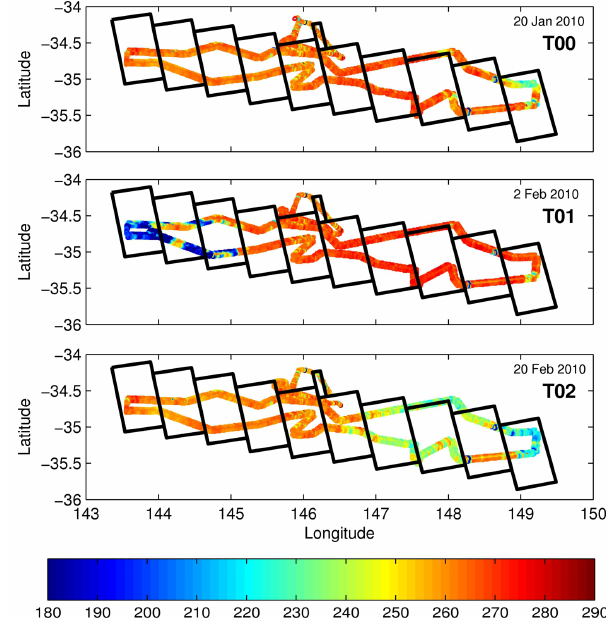
Fig. 8. Example of airborne L-band data collected at H-polarization during the AACES-1 campaign in transect flight mode (brightness temperatures given in